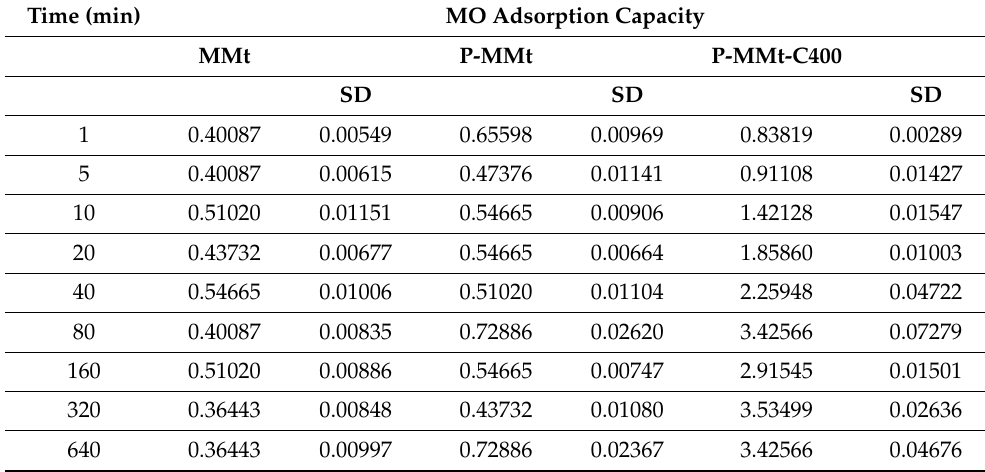
Table A2. The MO adsorption capacities of MMt, P-MMt, and P-MMt-C400 in various times. Time